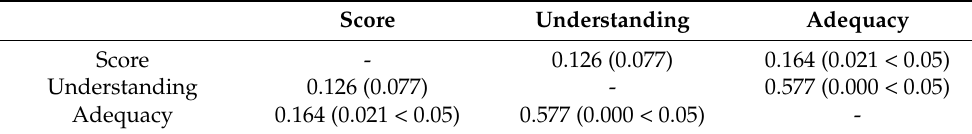
Table 6. Pearson’s correlation coefficient (significance level = 0.05).